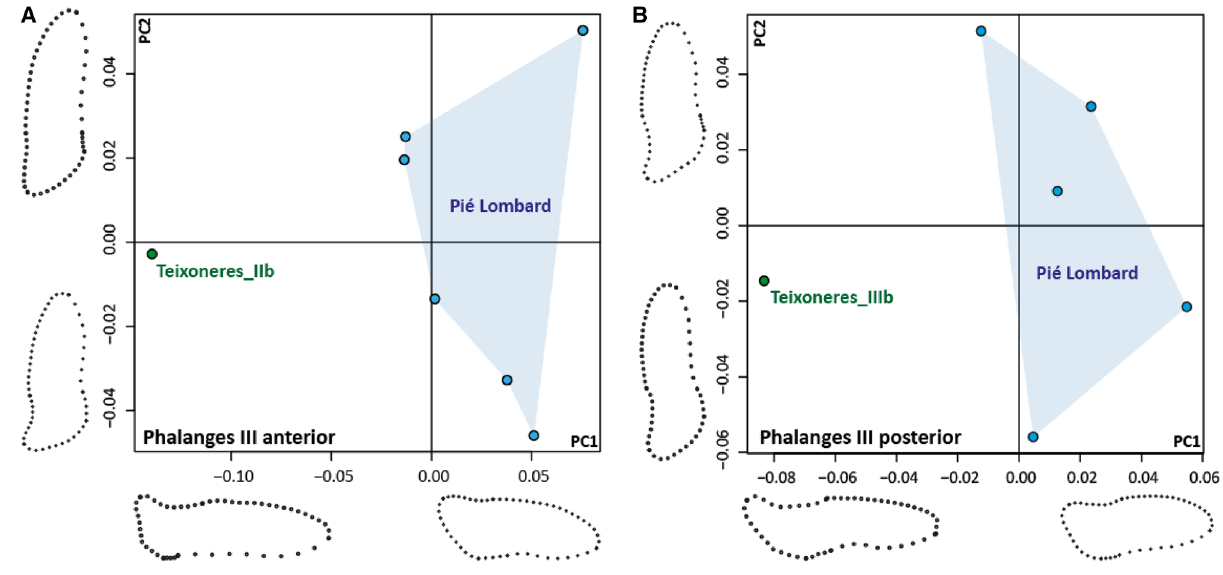
Figure 6. Principal components (PC) scatterplot with a visualisation of shape variation along PC1 and PC2: A: PC1 (65.38%) and PC2 (15.27%) performed on the shape data of the third anterior phalanges according to the